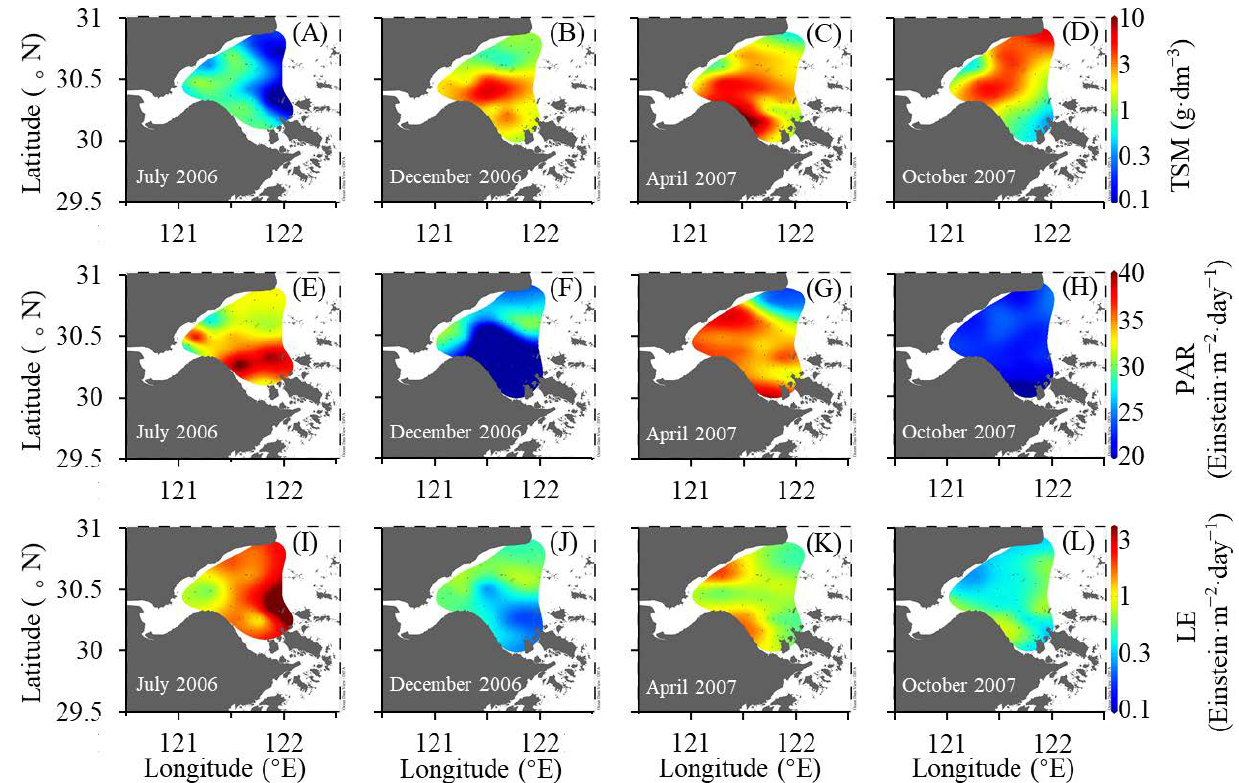
Figure 3. Spatial and temporal variations of ( A – D ) TSM (g · dm − 3 ), ( E – H ) PAR (Einstein · m − 2 · day − 1 ) and ( I – L ) LE (Einstein · m − 2 · day − 1